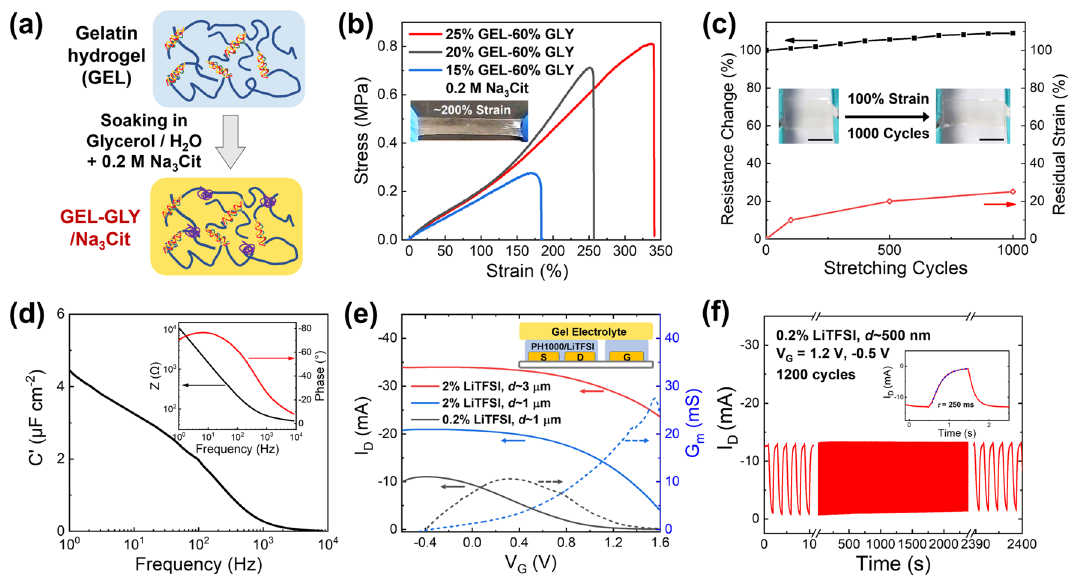
Fig. 2 a Preparation process of gelatin electrolyte by solvent exchange with glycerol solution containing 0.2 M sodium citrate. b Tensile stress–strain curves of the as-prepared GEL-GLY/Na 3 Cit having various gelatin compositions. Inset photo shows the gel electrolyte withstand- ing ~ 200% strain. c The percentages of resistance change and residual elongation of 25% GEL–60% GLY/Na 3 Cit during 1000 cycles of stretch- ing at 100% strain. Inset photos indicate the slight shape change after the stretching cycles, scale bars are 1 cm. d Frequency-dependent specific capacitance of the gel electrolyte at 1 to 10 4 Hz. Inset shows the plot of phase angle and impedance with frequency. e Representative transfer curves with the corresponding transconductance ( G m ) progressions of planar OECTs composed of GEL-GLY/Na 3 Cit solid-state electrolyte and LiTFSI-doped PEDOT:PSS (PH1000) channel materials on Au electrodes ( W/L = 5000/200 μm). The conductance modulation behavior was tuned by varying the channel film thickness or LiTFSI concentration. All the gate electrodes were coated with PEDOT:PSS/2% LiTFSI ( d ≈ 3 μm). f Plot of long-term I D switching with alternating V G between − 0.5 and 1.2 V with a 1 s pulse period. Inset displays the response time ( τ ) of ~ 250 ms upon applying the V G of 1.2 V, as estimated by exponential fitting. The channels were biased at V D = − 0.5 V in ( e ) and ( f